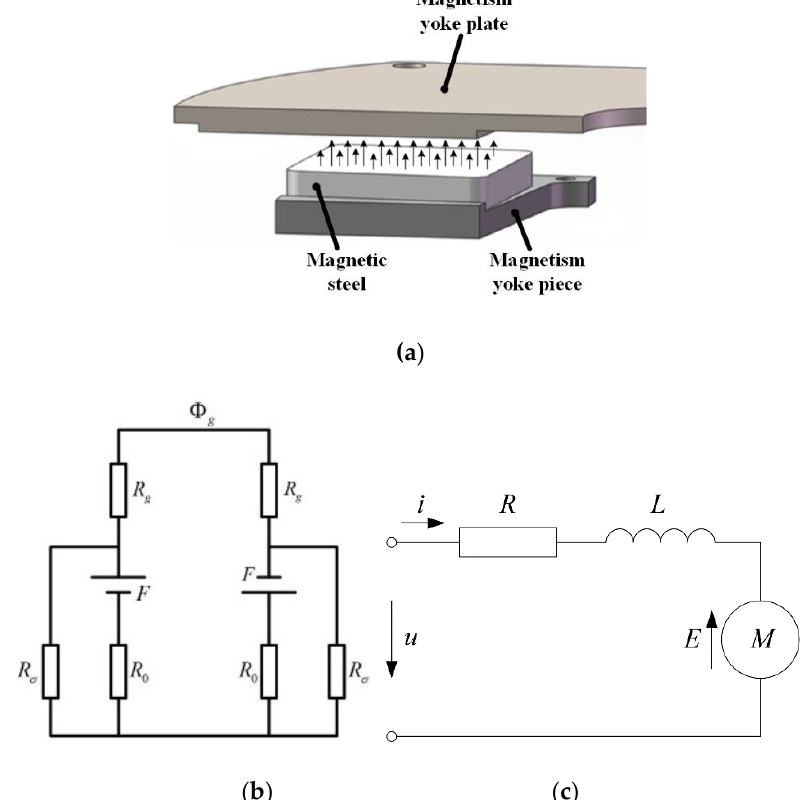
Figure 6. The composition of the ultralight VCM. ( a ) VCM and Hall effect sensor sectional view; ( b ) micro-magnetic steel working principle.